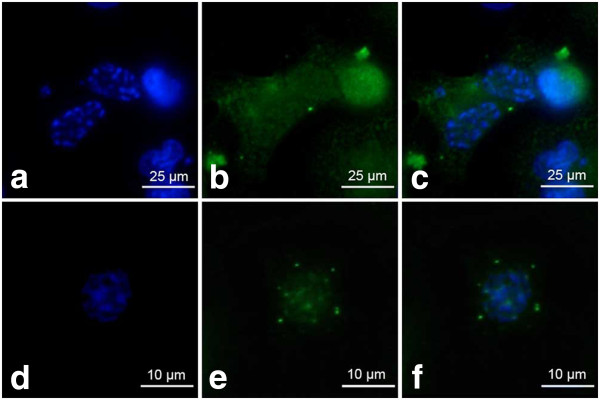
a-f p21Cip1/Waf1/Sdi1 and cyclin D1 are dispersed in the cells with SAHF – fluorescence microscopic examination (staining as described above). a-c 0.75 μM etoposide, d-f 3 μM etoposide; a, d DAPI, b p21Cip1/Waf1/Sdi1 labeling, e cyclin D1 labeling, c, f merged. Upper bar 25 μm, lower bar 10 μm.